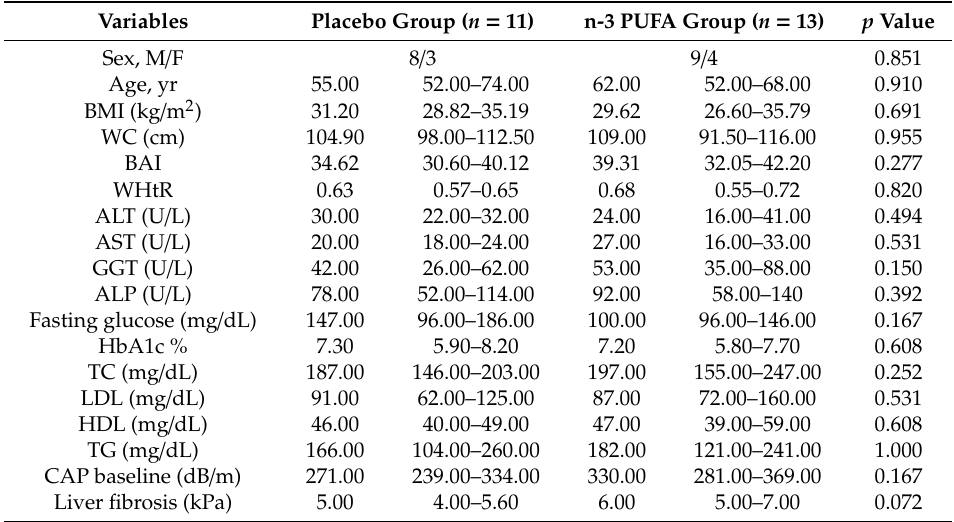
Table 1. Demographic, clinical, and biochemical variables of patients with non-alcoholic fatty liver disease (NAFLD) included in the study.